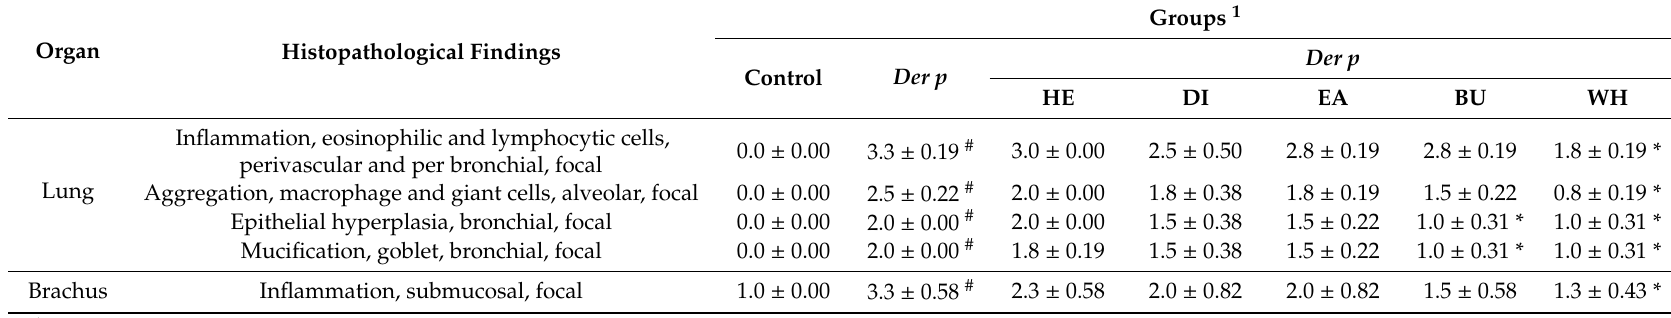
Table 1. Quantitative summary of the protective e ff ects of di ff erent fraction extracts of garlic on Der p–induced allergic asthma based on histological observations.